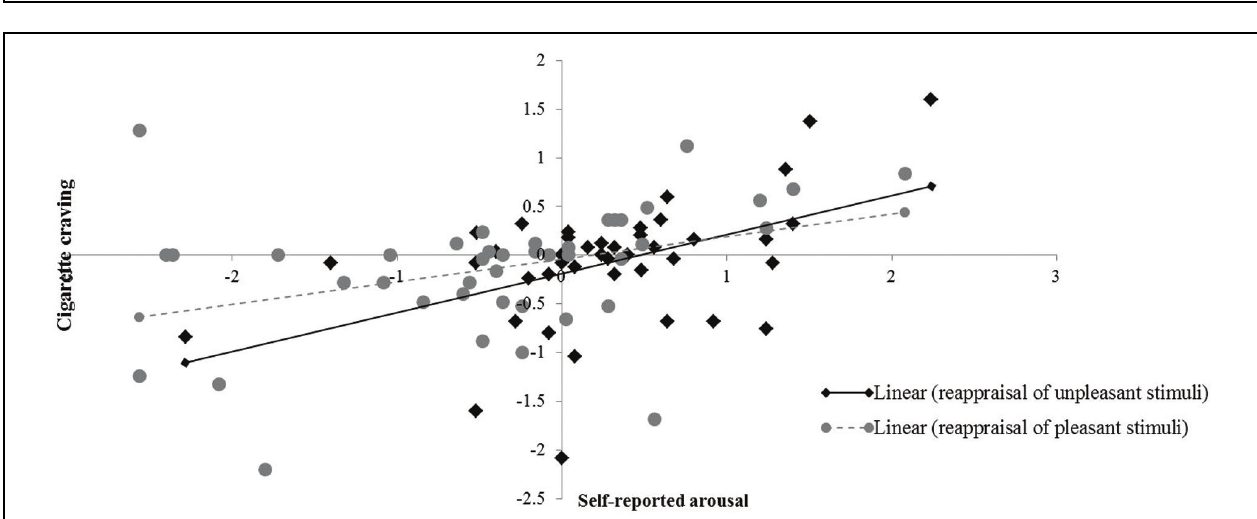
FIGURE 4 | Mean changes in LPP activity. Depicted are difference scores (specific condition minus neutral baseline condition; see Materials and Methods) in LPP activity as a function of reappraisal among NS, NDS, and DS. The more positive difference scores represent larger LPP activity under specific emotion condition comparing to baseline condition. Error bars represent standard error of the mean (SEM). ∗ p < 0.05.